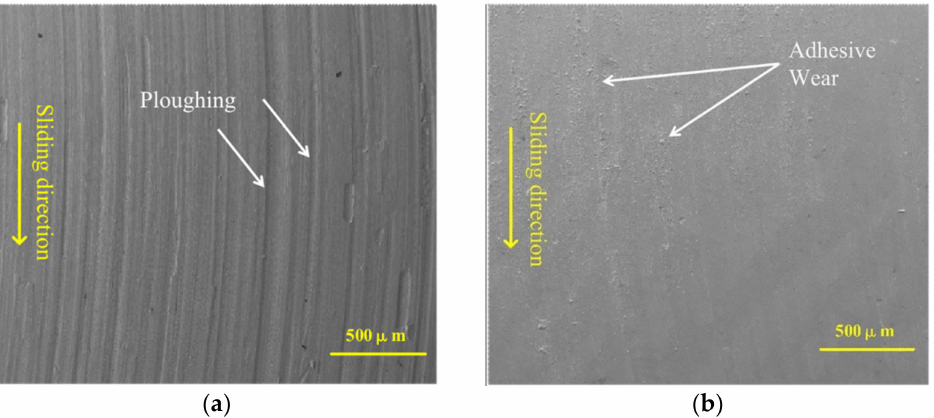
Figure 10. SEM images on the worn surface of the copper pin after working under a load of 15 N for ( a ) 180 s; and ( b ) 1800 s,